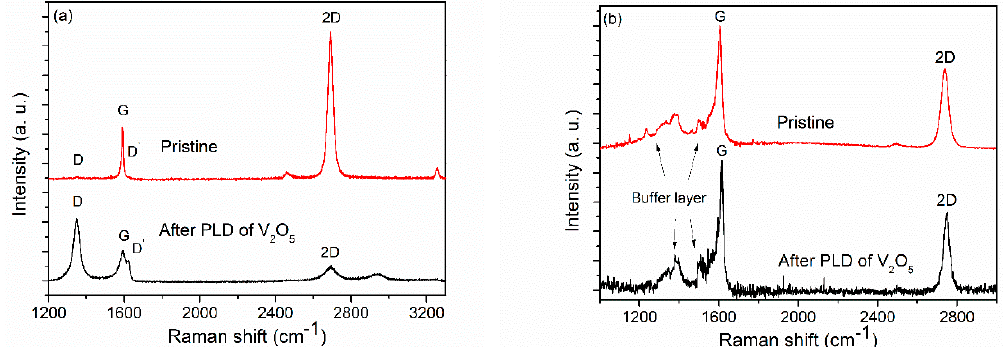
Figure 3. ( a ) Typical Raman spectra of CVD graphene in sensor device, recorded between the electrodes before and after laser deposition of V 2 O 5 : strong defect related peaks D and D’ emerge after deposition of V 2 O 5 . ( b ) Raman spectra of SiC/EG before and after deposition of V 2 O 5 . Lower signal to noise ratio in the lower trace was due to diminished laser power by a factor of 17. Defect related peaks D and D’ were not created noticeably in case of SiC/EG/V 2 O 5 .